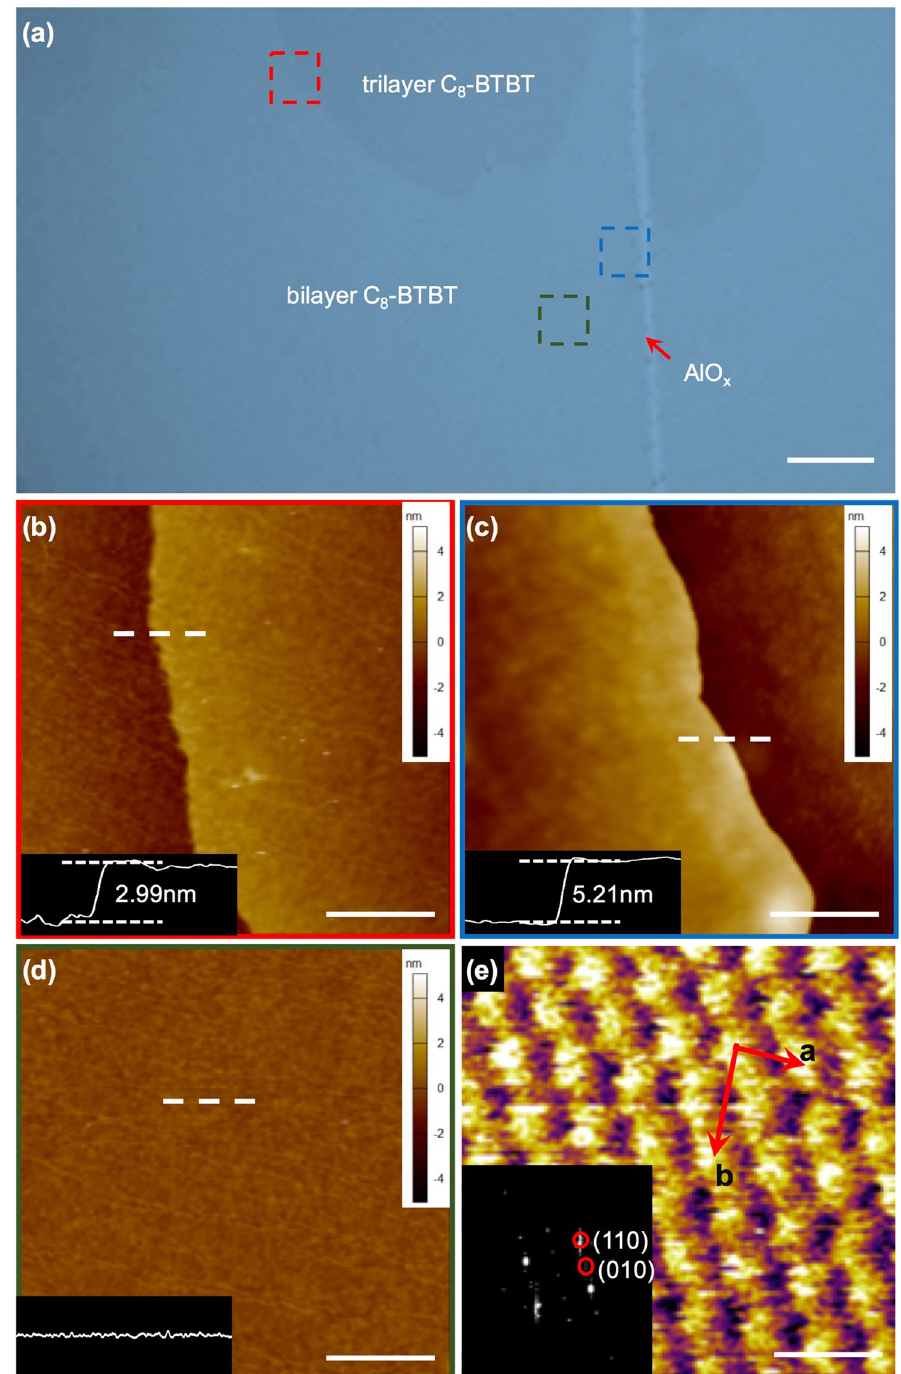
Figure 2. ( a ) Optical microscopy image of the 2D C 8 -BTBT crystalline films. The bilayer and trilayer are clearly observed. Scale bar, 20 μ m. ( b ) AFM morphology image of the step between bilayer and trilayer films (red square in ( a )). Scale bar, 500 nm. ( c ) AFM morphology image of the step between bilayer films and the substrate (blue square in ( a )). Scale bar, 500 nm. ( d ) AFM morphology image of uniform bilayer films (brown square in ( a )). Scale bar, 500 nm. ( e ) High-resolution AFM image of the bilayer C 8 -BTBT molecules on the AlO x /Si substrate. Scale bar, 1 nm. The inset shows the corresponding fast Fourier transforms of the AFM image with lattice